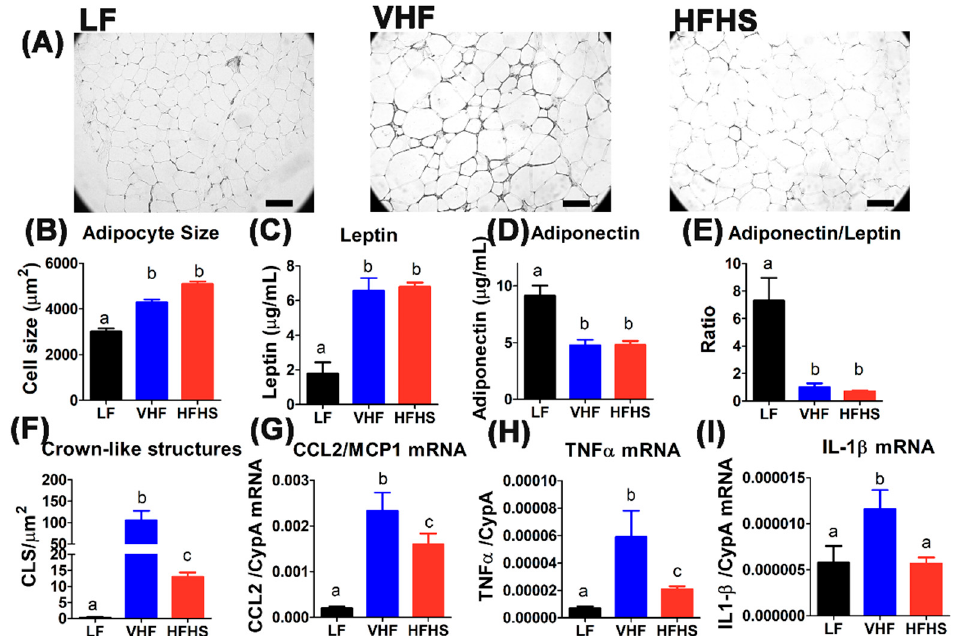
Figure 4. Hypercaloric diet with excess fat promotes adipose tissue inflammation. Epididymal adipose tissues were collected from C57BL / 6J mice fed low fat (LF), very high fat (VHF), or moderately high fat with excess sucrose (HFHS) diets for 12 weeks. Representative adipose tissue section images are shown in ( A ). ( B ) Adipocyte size was determined by measuring the size of 160 adipocytes from 10 LF-fed mice and 475 adipocytes from 12 VHF-fed and 12 HFHS-fed mice. Data groups with letter a are statistically di ff erent from data groups with letter b at p < 0.01 (1-way ANOVA with Bonferroni post hoc analysis). Plasma leptin ( C ) and adiponectin ( D ) levels were determined from 10 LF-fed mice, 14 VHF-fed mice, and 17 HFHS-fed mice. The data were used to determine adiponectin / leptin ratio ( E ). Number of crown-like structures detected in adipose tissues sections of 10 LF-fed, 12 VHF-fed, and 12 HFHS-fed mice is shown in ( F ). Data groups with letter a are significantly di ff erent from data groups with letter b at p < 0.01 (1-way ANOVA with Bonferroni post hoc analysis). RNA extracted from adipose tissues of 7 mice in each group to measure expression levels of CCL2 / monocyte chemoattractant protein-1 (MCP1) ( G ), tumor necrotic factor- α (TNF α ) ( H ), and interleukin-1 β (IL-1 β ) ( I ). The gene expression data with di ff erent letters indicate statistically significant di ff erence at p < 0.05 (1-way ANOVA with Bonferroni post hoc analysis).